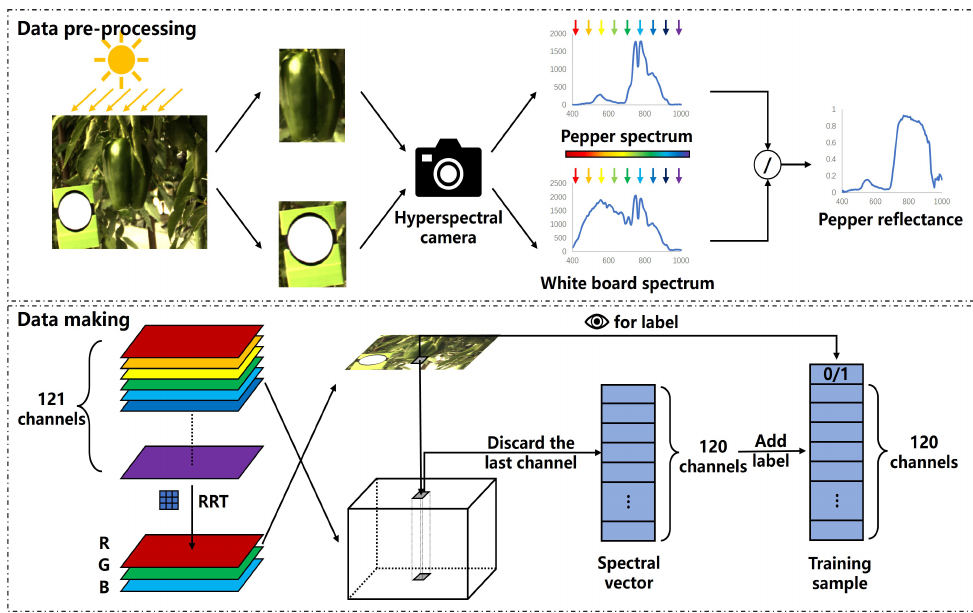
Figure 1. Data pre-processing and making process. Different color arrows on the spectrum represent different light intensities for each wavelength. RRT is short for RGB response